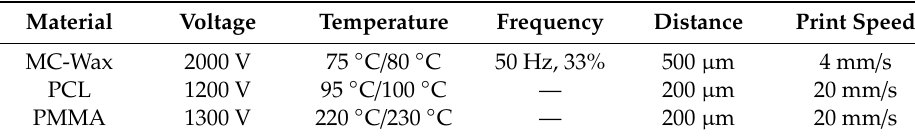
Table 2. Printing parameters of di ff erent materials.